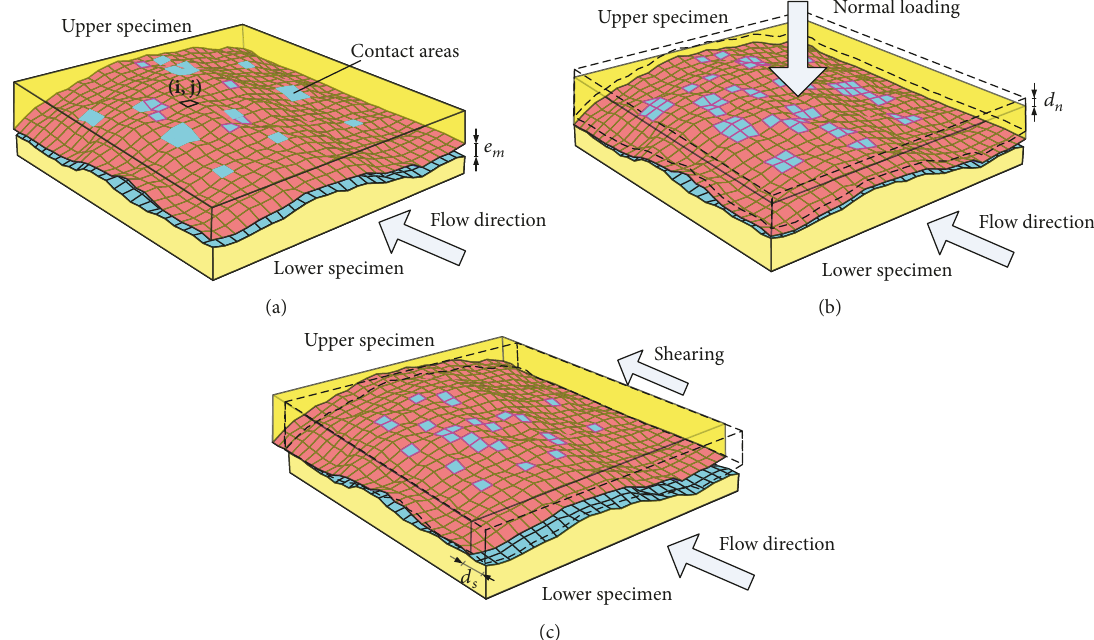
Figure 4: Schematic diagram of void space geometry at normal 𝑑 𝑛 and shear displacement 𝑑 𝑠